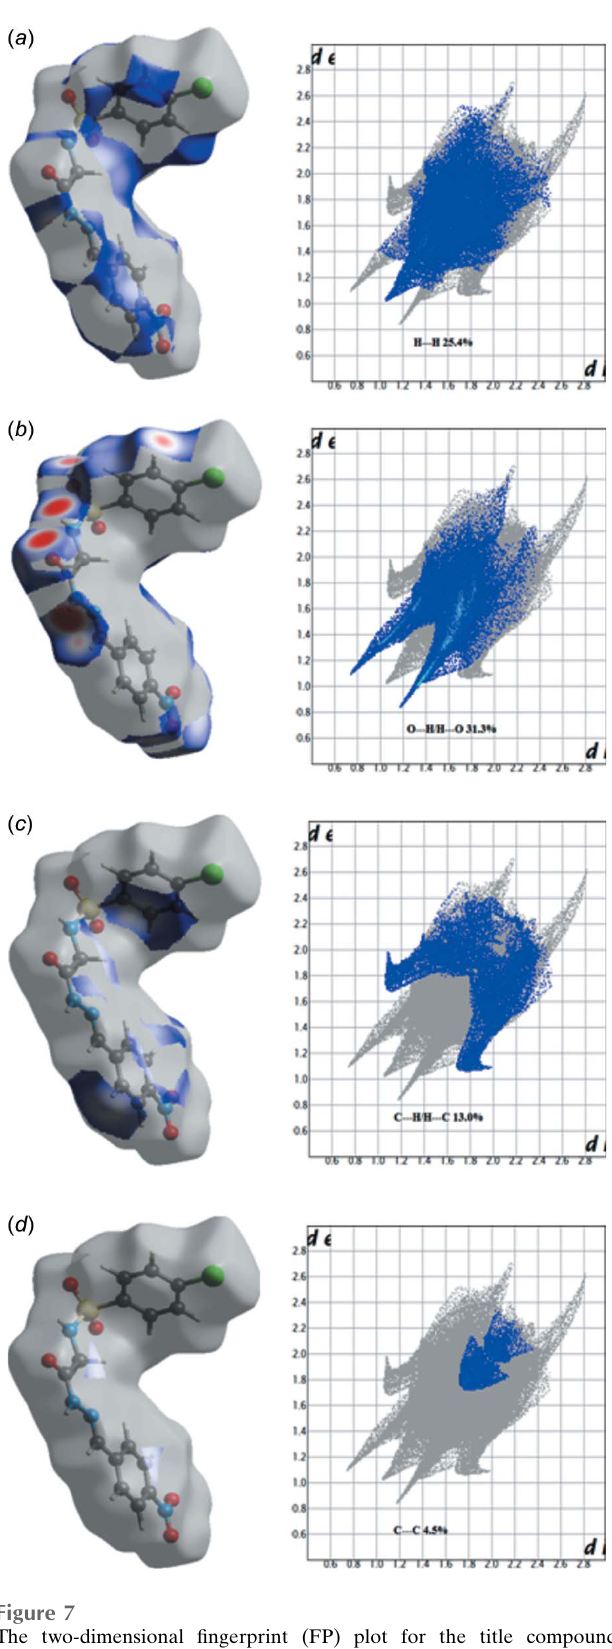
Figure 7 The two-dimensional fingerprint (FP) plot for the title compound, delineated into ( a ) O (cid:2)(cid:2)(cid:2) H/H (cid:2)(cid:2)(cid:2) O, ( b ) H (cid:2)(cid:2)(cid:2) H, ( c ) C (cid:2)(cid:2)(cid:2) H and ( d ) C (cid:2)(cid:2)(cid:2) C interactions; d norm surfaces for each plot, indicating the relevant surface patches associated with the specific contacts, are shown on the right.